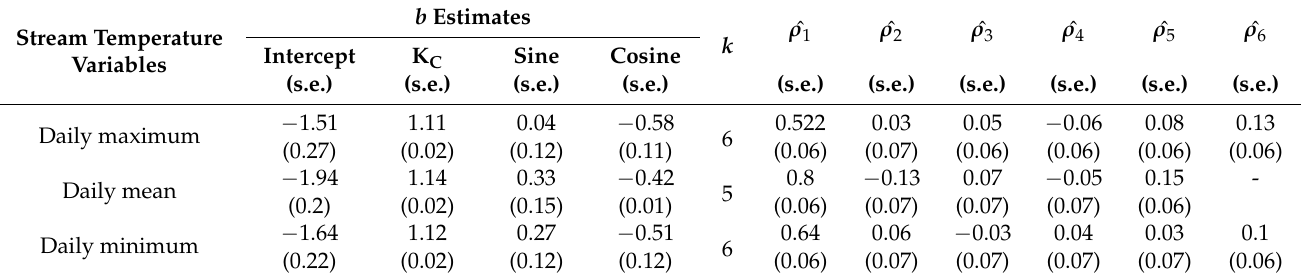
Table 2. Results of ARIMAX analysis for prethinning calibration.